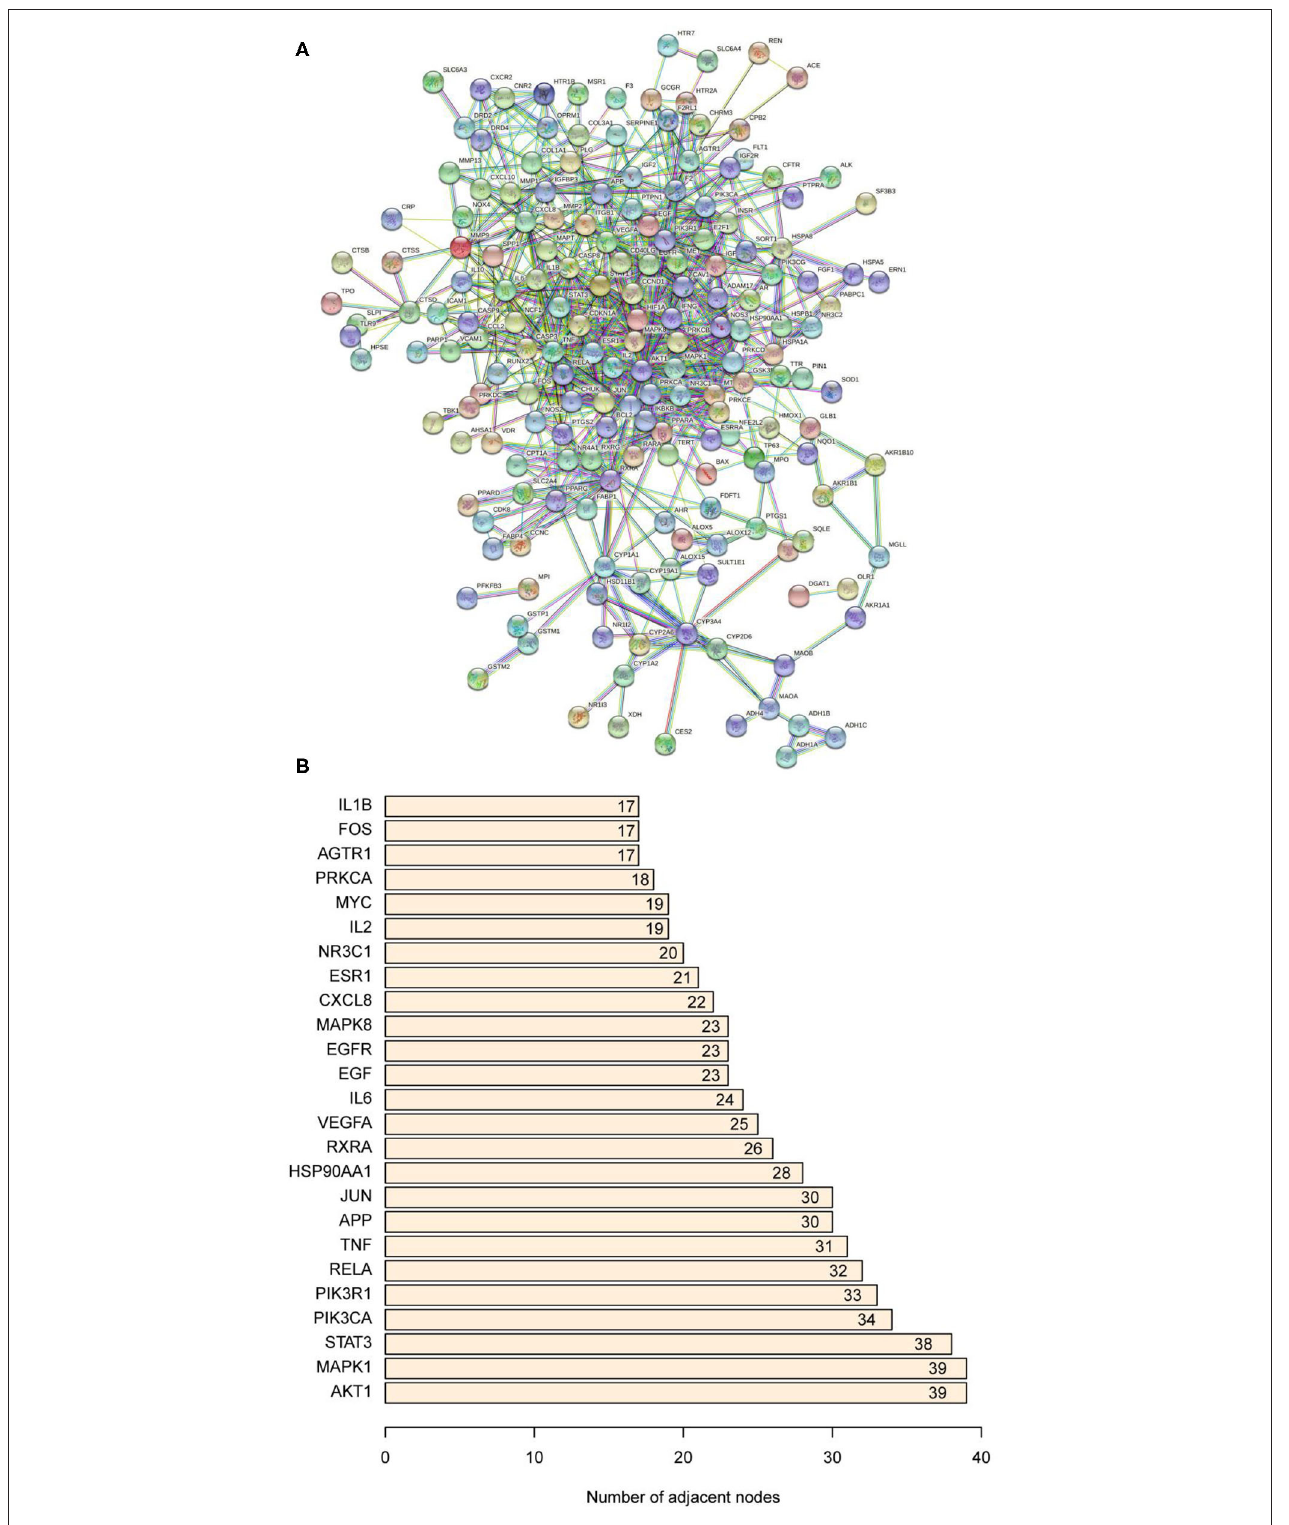
FIGURE 5 | (A) Protein-protein interaction network. (B) The bar plot of the protein-protein interaction network. The X -axis represents the number of neighboring proteins of the target protein. The Y -axis represents the target protein.